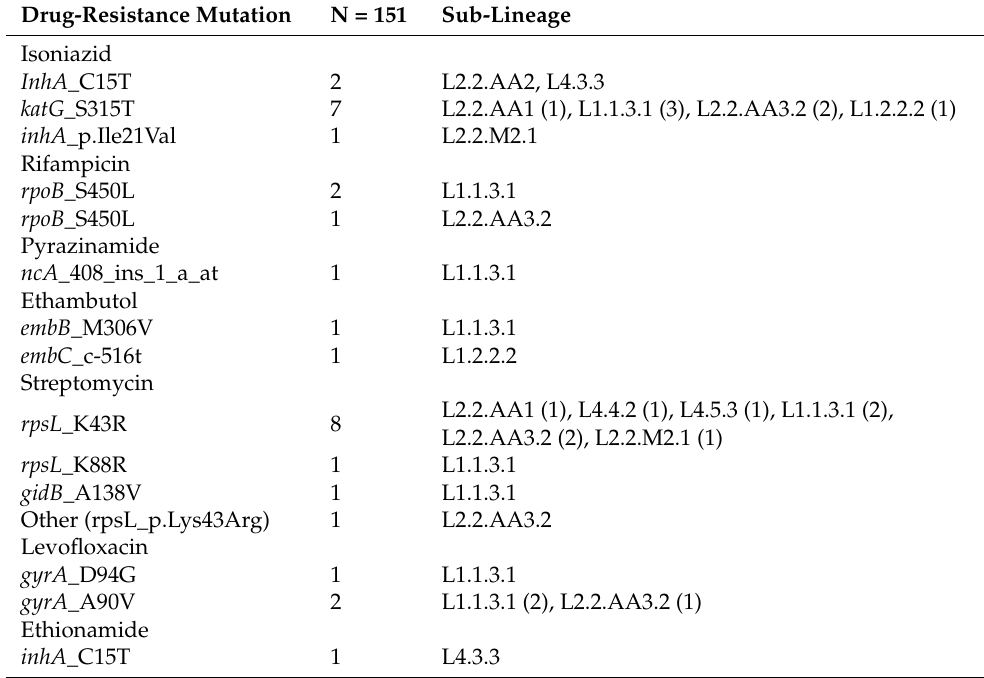
Table 3. Frequency distribution of drug-resistance mutation and sub-lineages in Mandalay region. Drug-Resistance Mutation N = 151